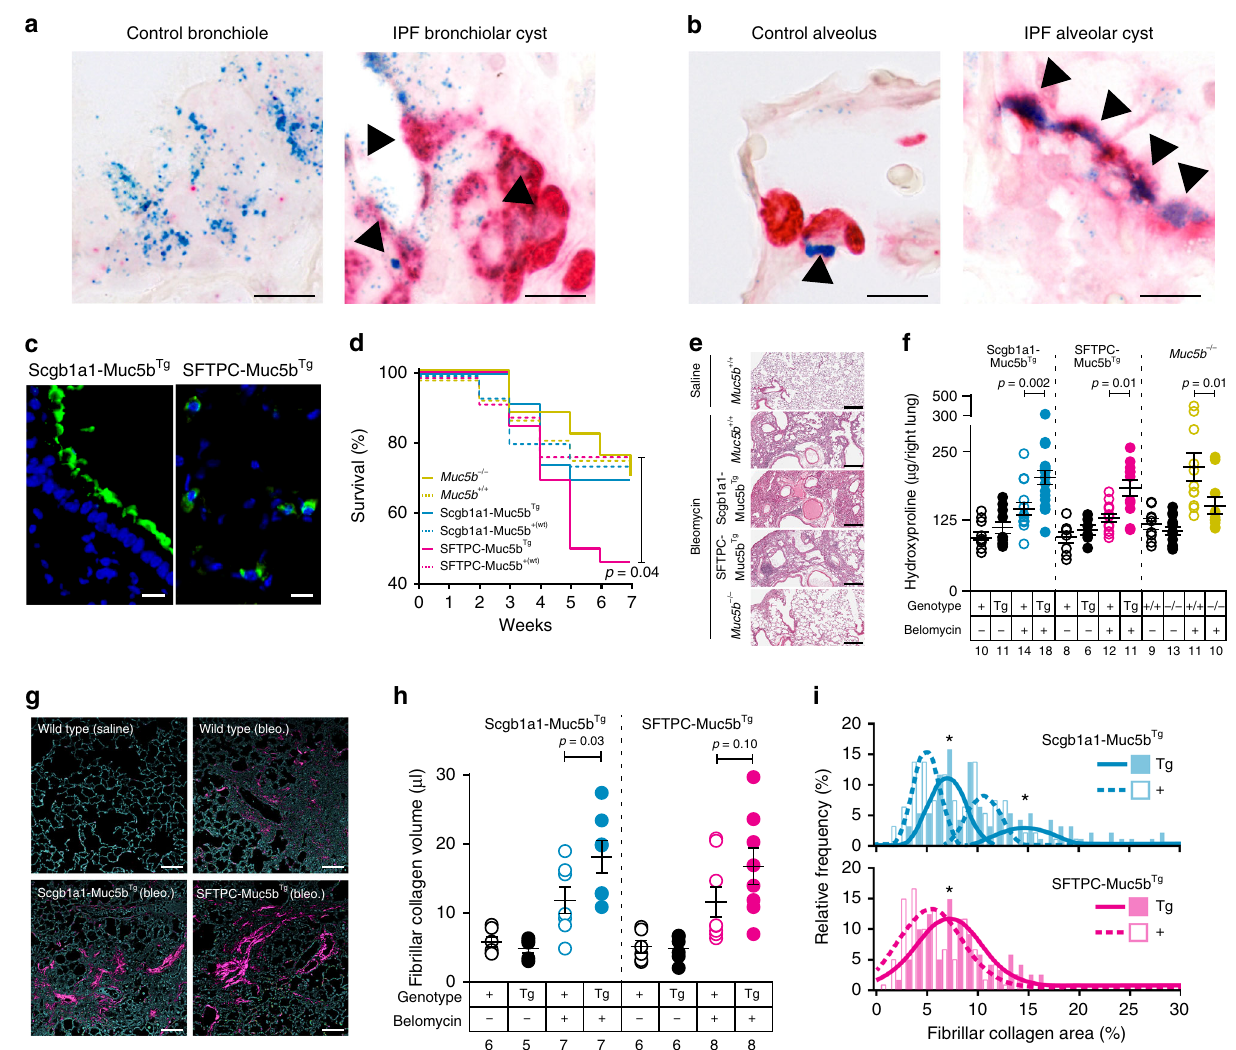
Fig. 1 Muc5b overexpression in the distal lung is associated with greater fi brogenesis following bleomycin. a , b In situ hybridization of human lung specimens from control and IPF subjects with MUC5B variant rs35705950. Arrowheads depict cells co-expressing SFTPC (red) and MUC5B (blue) in control bronchioles and IPF bronchiolar structures a and in control type 2 alveolar epithelia and IPF type 2 alveolar structures b . c Transgenic mice expressing Muc5b under control of the mouse Scgb1a1 and the human SFTPC promoters demonstrate Muc5b protein in conducting airways and in type 2 alveolar epithelia. d , e After repeated doses of bleomycin (2.5 U/kg, IT on day 0, 1.5 U/kg on days 14 and 28), SFTPC-Muc5b Tg demonstrated worse survival d and tissue injury e relative to wild type ( + ) littermates. Survival data in d were evaluated by χ 2 statistic using 17 Muc5b − / − , 16 Muc5b + / + , 15 Scgb1a1- Muc5b Tg , 23 Scgb1a1-Muc5b + (wt) , 26 SFTPC- Muc5b Tg , and 25 SFTPC- Muc5b + (wt) , mice. f – i Scgb1a1- Muc5b Tg , Muc5b − / − , and control mice were treated IT with bleomycin as in d . To induce similar levels of fi brosis while limiting survivor bias, SFTPC-Muc5b Tg and controls received 2.0 U/kg bleomycin on day 0, followed by 1.0 U/kg on days 14 and 28. HP content increased in Scgb1a1-Muc5b Tg and SFTPC-Muc5b Tg but decreased in Muc5b − / − mice compared to wild type ( + ) controls for each strain. g – i Fibrillar collagen (magenta in g ) was assessed in peripheral lung tissues by confocal/multi- photon fl uorescence microscopy with SHG. h , i Fibrillar collagen volumes following bleomycin were increased per mouse h and showed heterogeneous distributions i in Tg mice compared to controls. Data in i were analyzed by t- test ( n = 105 Scgb1a1-Muc5b Tg and 105 Scgb1a1-Muc5b + (wt) images, and n